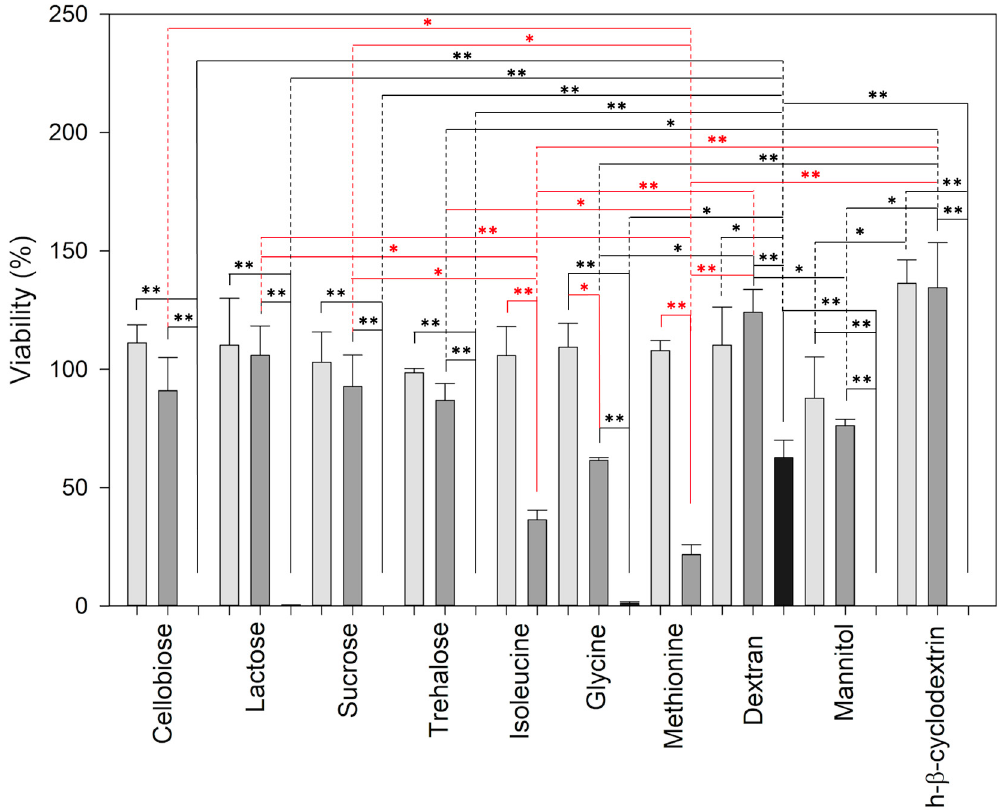
Figure 5. The graph represents the viability of Daudi after 48 h of treatment with the different excipients. Light grey is 1 mg/mL, dark grey is 10 mg/mL, and black is 100 mg/mL. Data are displayed as mean ± SE. ** for p ≤ 0.001 and * for p ≤ 0.05. Black asterisks represent the comparison of excipients at the three concentrations, without isoleucine and methionine; red asterisks represent all excipients at 10 and 1 mg/mL.